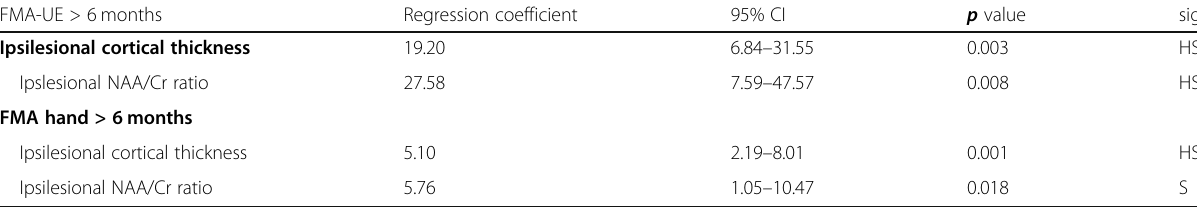
Table 4 Regression coefficient test for FMA – UE and FMA of the hand FMA-UE > 6 months Regression